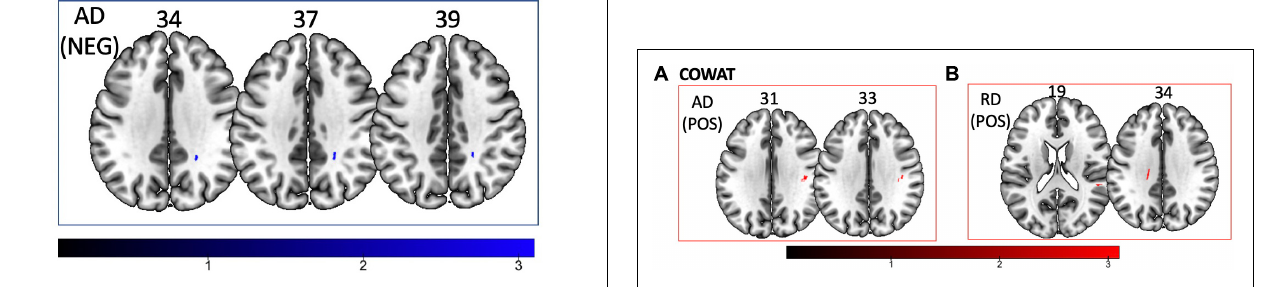
FIGURE 4 | Significant correlations between COWAT scores and (A) AD and (B) RD values ( p < 0.05, cluster-wise FDR corrected for multiple comparisons). Pictures are in neurological convention with left side in the figure corresponding to the left side of the